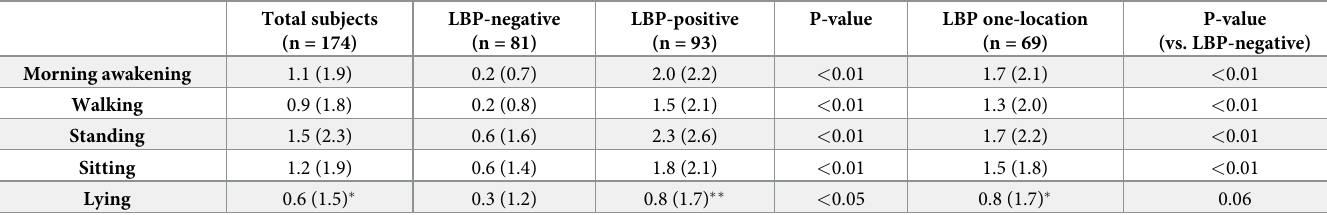
Table 2. Characteristics of low back pain intensity.